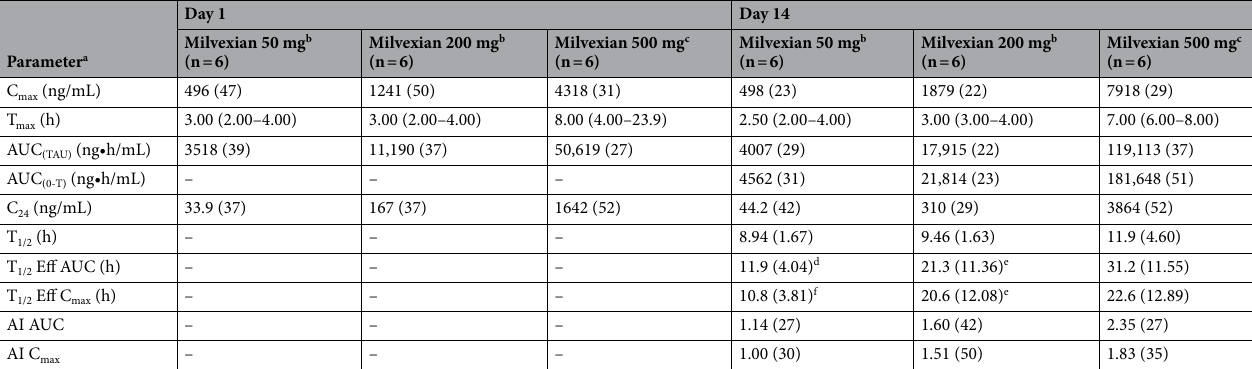
Table 3. PK parameters on Day 1 and Day 14. PK, pharmacokinetics; C max , maximum observed plasma concentration; T